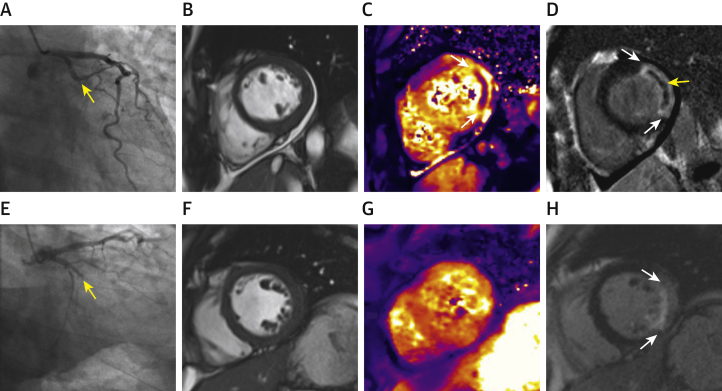
Smoking and Myocardial Hemorrhage After Acute ST-Segment Elevation Myocardial InfarctionCurrent smoker (A to D) and nonsmoker (E to H) who underwent primary percutaneous coronary intervention (PCI) for lateral ST-segment elevation myocardial infarction. Both had TIMI (Thrombolysis in Myocardial Infarction) flow grade 3 post-PCI. Antithrombotic therapies, including aspirin, clopidogrel, and unfractionated heparin, were similar for both patients. Magnetic resonance imaging (MRI) was performed 2 days and 6 months later. (A to D) Imaging from a 58-year-old male current smoker. Symptom-to-balloon time was 8.5 h. Angiography revealed a proximally occluded circumflex coronary artery (yellow arrow, A). Two days later, myocardial hemorrhage was revealed by T2* mapping (white arrow, C). Late gadolinium enhancement revealed transmural infarction of the lateral left ventricular (LV) wall (white arrows, D) associated with microvascular obstruction (MVO) (yellow arrow, D). Baseline infarct size was 32.3%, LV ejection fraction 55%, and LV end-diastolic volume indexed to body surface area (LVEDVi) 83.8 ml/m2. Six months later, infarct size was 31.2% and LVEDVi 84.8ml/m2, consistent with adverse remodeling. (E to H) Imaging from a 48-year-old male nonsmoker. Symptom-to-balloon time was 9.3 h. Angiography revealed a proximally occluded circumflex coronary artery (yellow arrow, E). Two days later, there was no evidence of myocardial hemorrhage (G) or MVO within the infarct zone (H) on MRI. Baseline infarct size was 25.3%, LV ejection fraction 51%, and LVEDVi 78.4 ml/m2. Six months later, infarct size was 15.2% and LVEDVi 72.7 ml/m2.